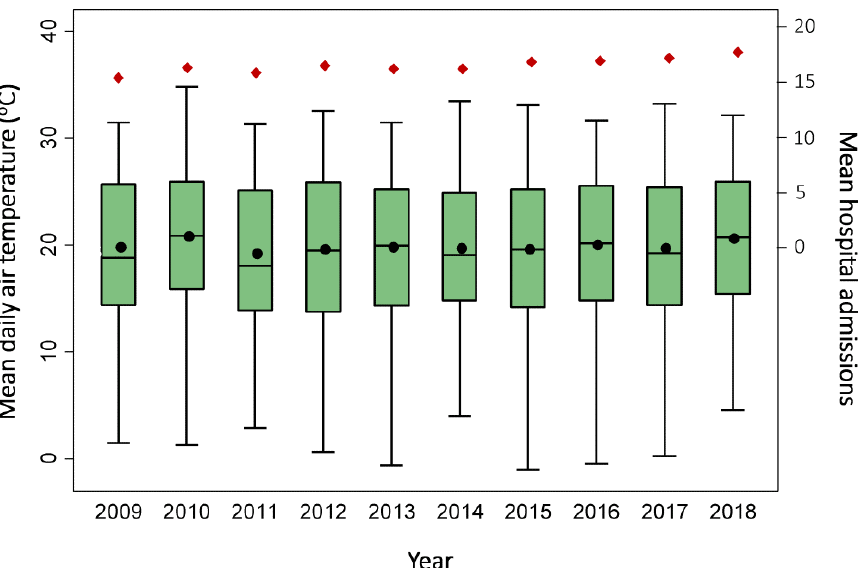
Figure 2. Box plot of variation of mean daily air temperature and mean hospital admissions per 100,000 population (red diamonds) in Cyprus over the years 2009–2018.